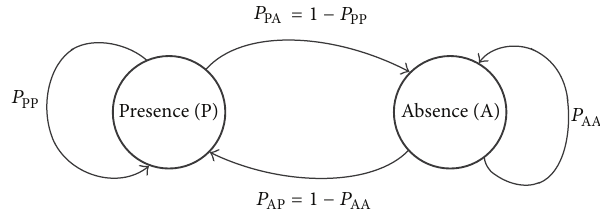
Figure 1: Markov chain states of the